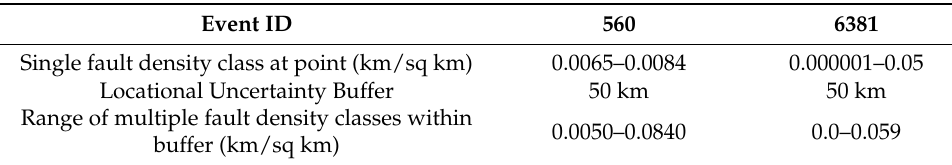
Table 5. Impact of location uncertainty: buffered area values vs. point value of fault density factor class, for events 560 and 6381.